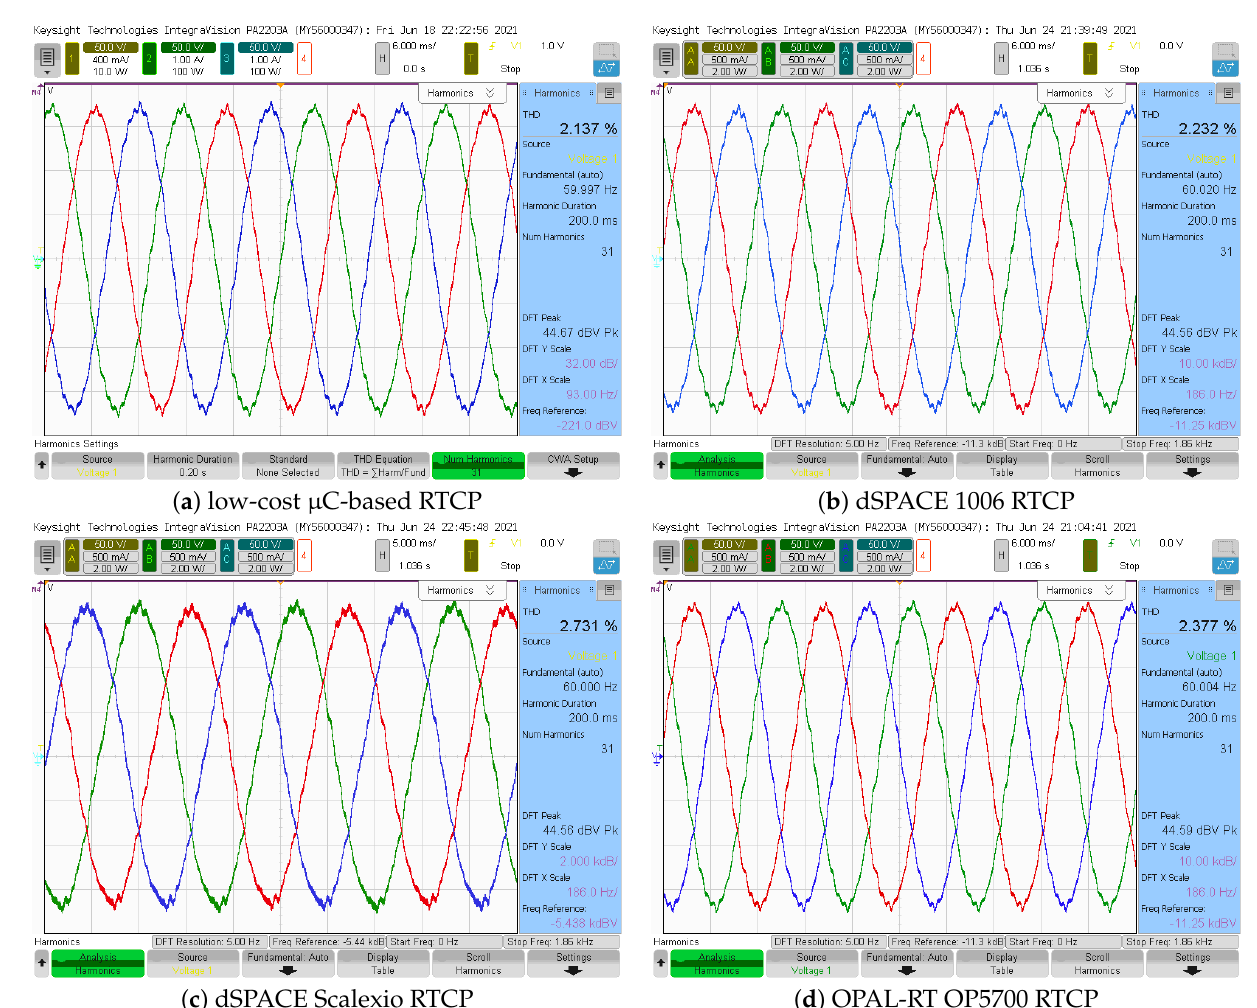
Figure 25. Best waveform achieved in Scenario 2: voltage harmonic controller at each